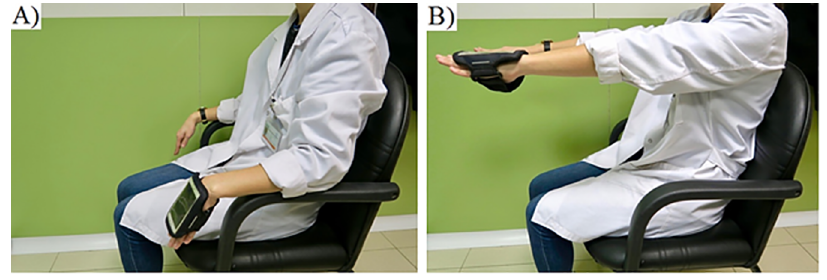
Fig 1. 1A, Recordingtremor in rest position. 1B, Recordingtremor in postural position.